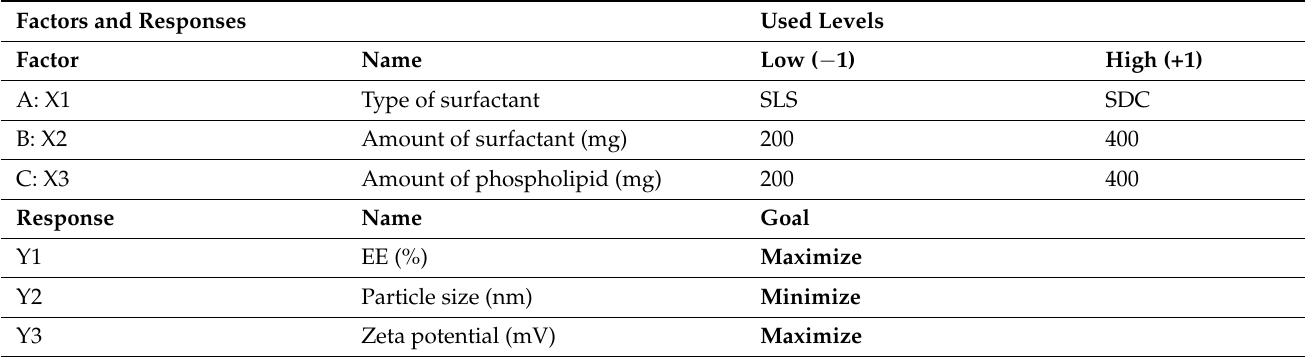
Table 1. The formulation factors and responses of 2ˆ3 full factorial design for ITZ-TFS formulations. Factors and Responses Used